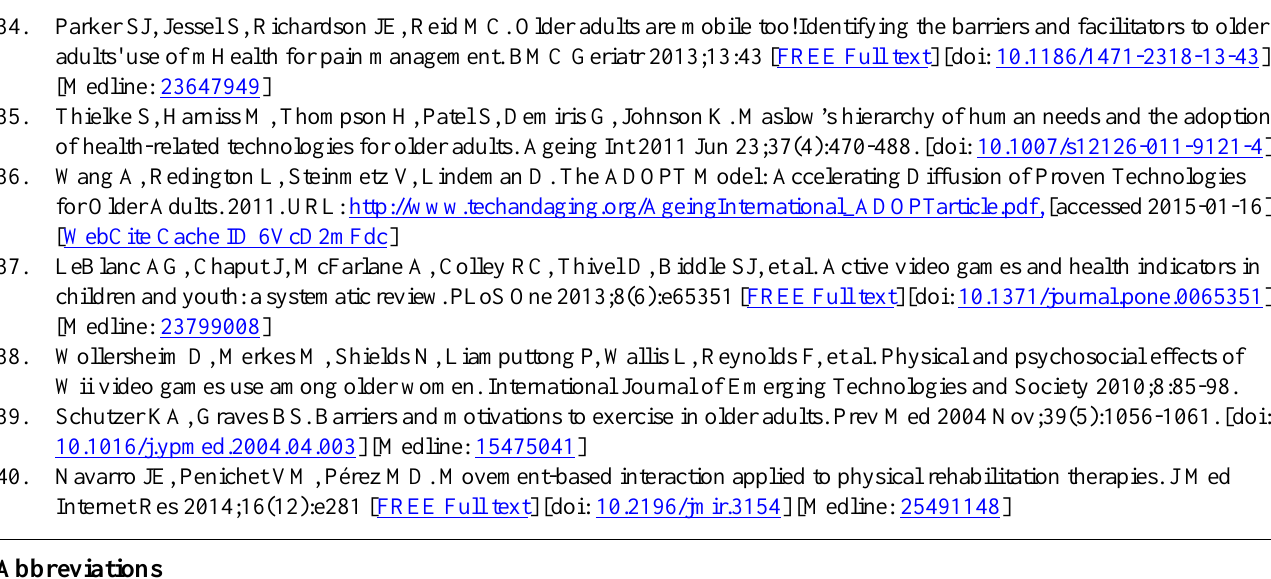
PACES: Physical Activity Enjoyment Scale TEA: Technology Engaging